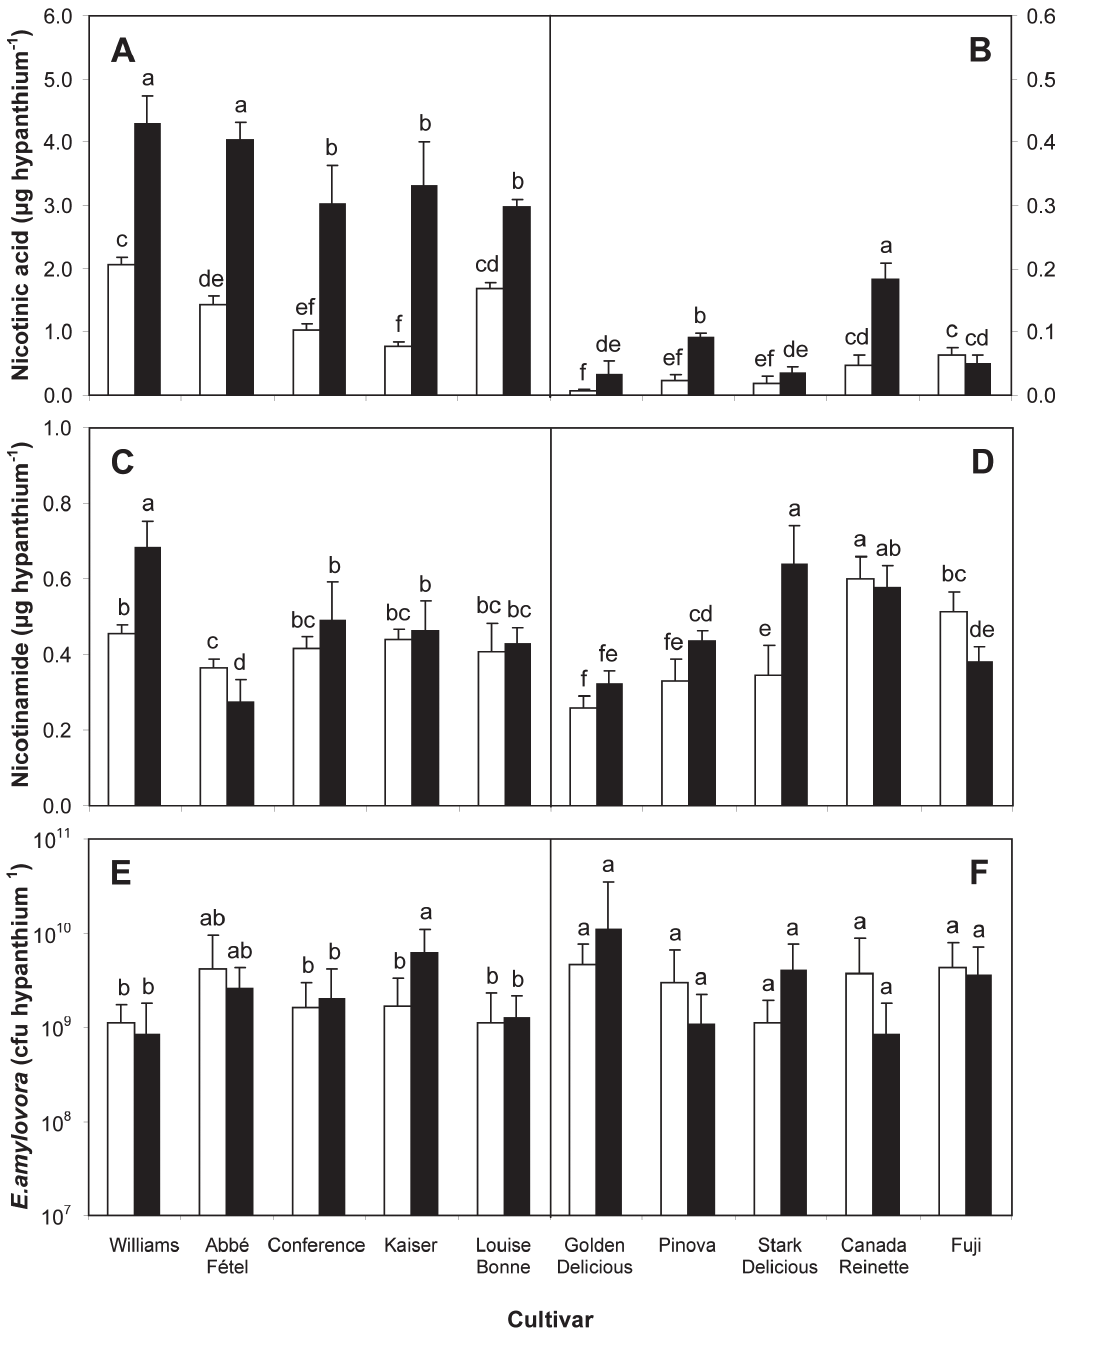
Figure 1. Amounts of nicotinic acid (A, B), nicotinamide (C, D) and Erwinia amylovora population (E, F) on hypan- thia of newly opened flowers of pear (A, C, E) and apple (B, D, F) cultivars at low (white bars) and high altitude sites (black bars). Flowers from at least three trees of five different cultivars each growing at two altitudes were used. Each value represents the mean of 10 samples (one sample = 15 newly opened flowers) (A, B, C, D). Flower hypanthia were mechanically inoculated with about 10 4 cfu of E. amylovora and each value represents the mean of 10 flowers from at least three trees (E, F). Vertical bars represent the standard deviation. Bars with a different letter are sig- nificantly different according to ANOVA and Tukey’s HSD post hoc-test ( α